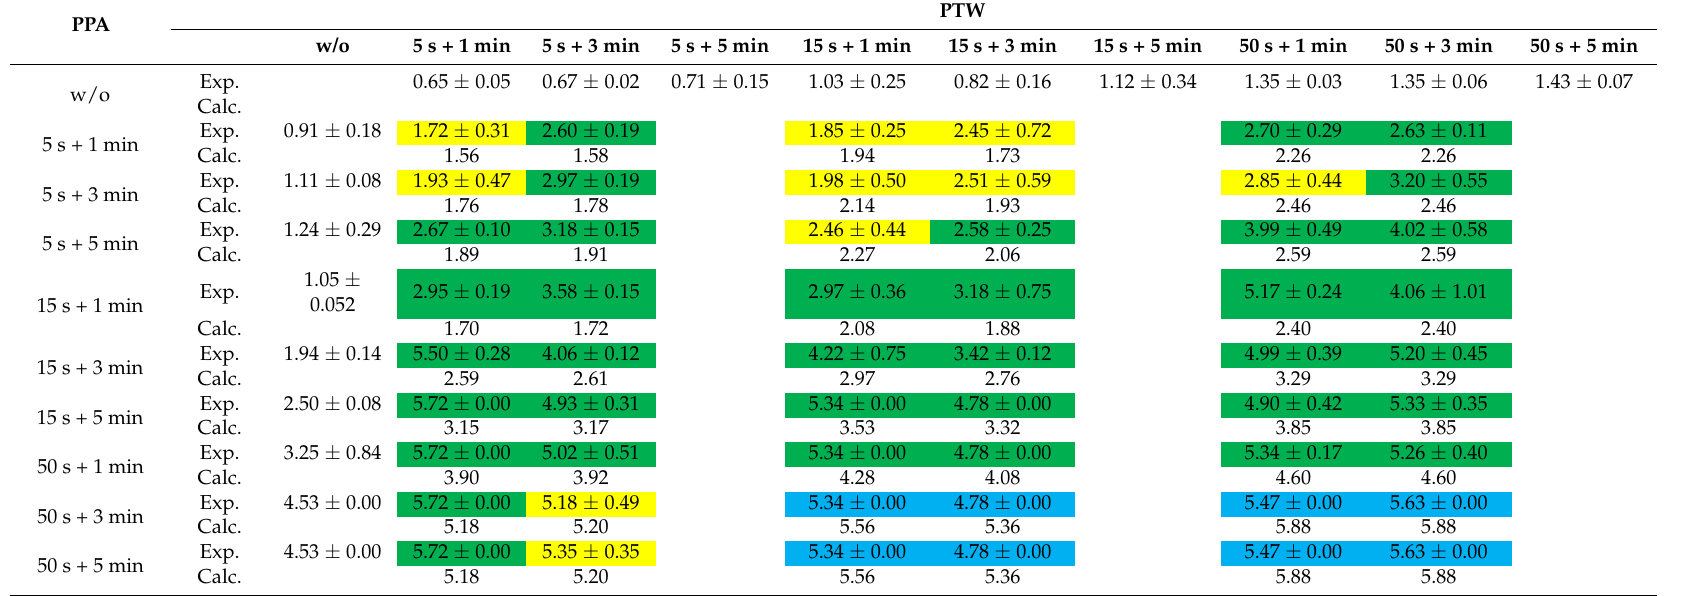
Table 4. Experimental and calculated data of separated and combined use of PPA (plasma-processed air) and PTW (plasma-treated water) under different pre- and post-treatment times for antimicrobial effects on L. monocytogenes . Color code for effects of combined PTW/PPA treatments: red = antagonistic, yellow = additive, green = synergistic, blue = detection limit reached within the experiments. w/o = without. Exp. = experimental, Calc.= calculated.